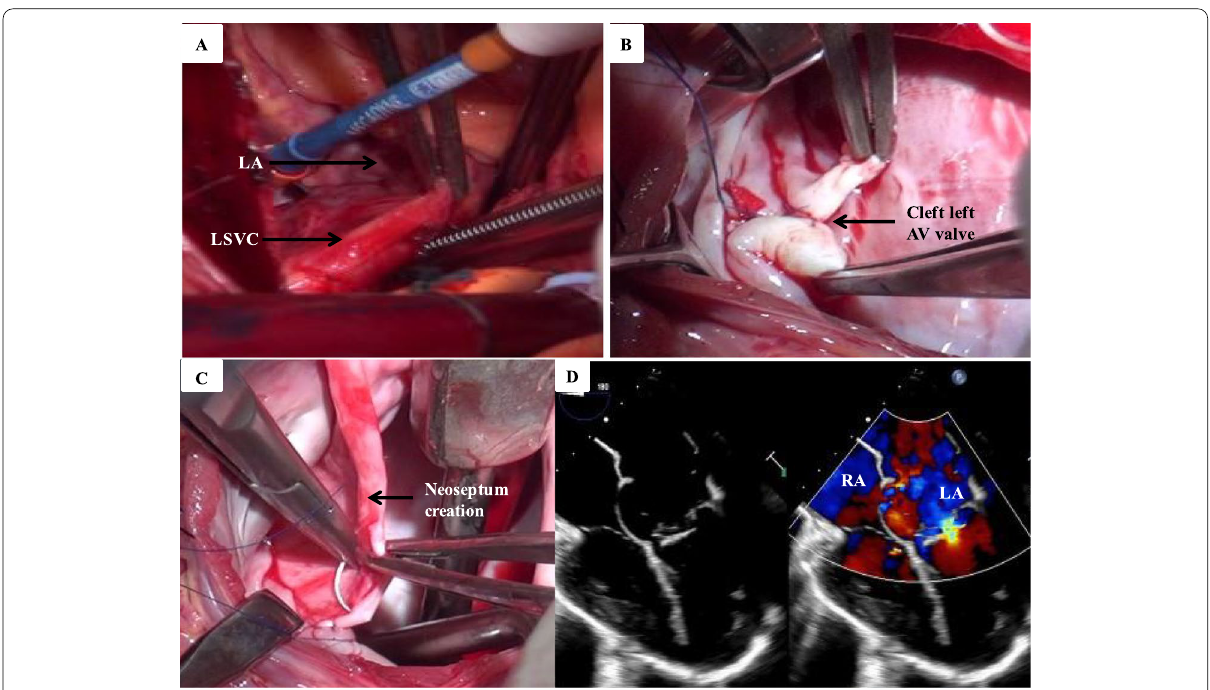
Fig. 3 Intraoperative images demonstrating the following: A LSVC draining to LA, B partially closed cleft of left AV valve, C creation of neo-septum using autologous untreated pericardium, D post repair transesophageal echocardiography demonstrating intact neo-septum with trivial left AV valve regurgitation